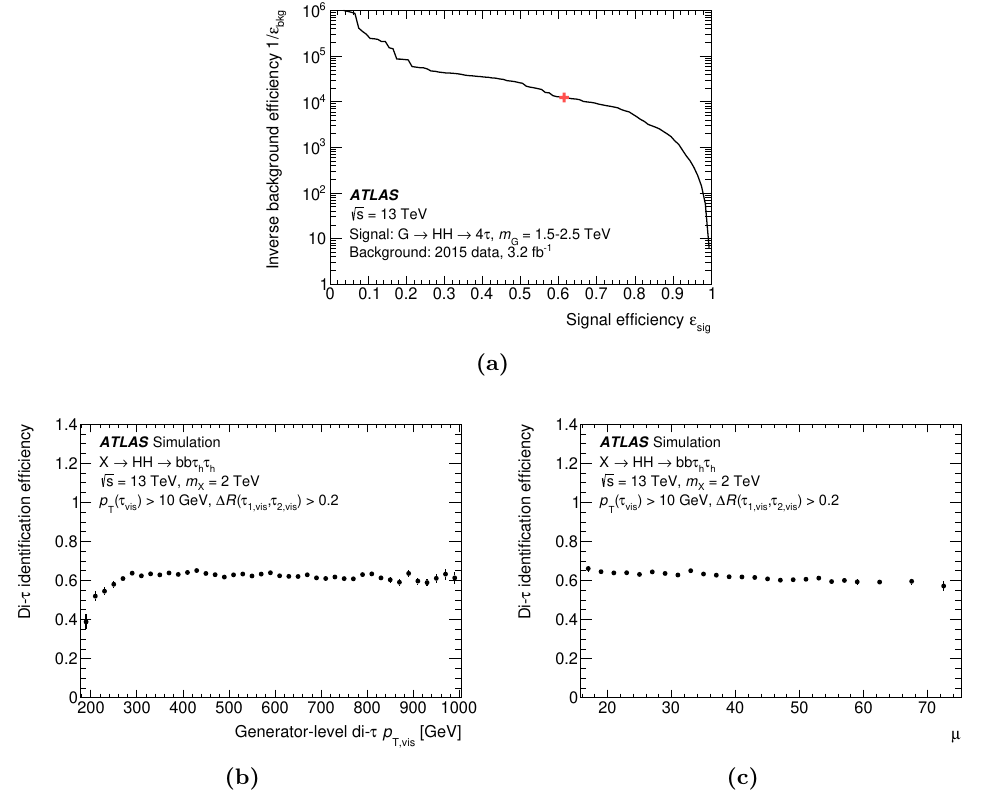
Figure 3. (a) Background rejection factor versus identification efficiency for the BDT used to discriminate between di- τ signatures and quark- or gluon-initiated jets, as obtained after the di- τ reconstruction step (the red cross indicates the benchmark used in the analysis, corresponding to a signal efficiency of about 60% and a background rejection factor of 10 4 ), and identification efficiency of boosted di- τ objects, as a function of (b) their p T at generator level and (c) the number µ of pile-up interactions. The vertical error bars only account for statistical